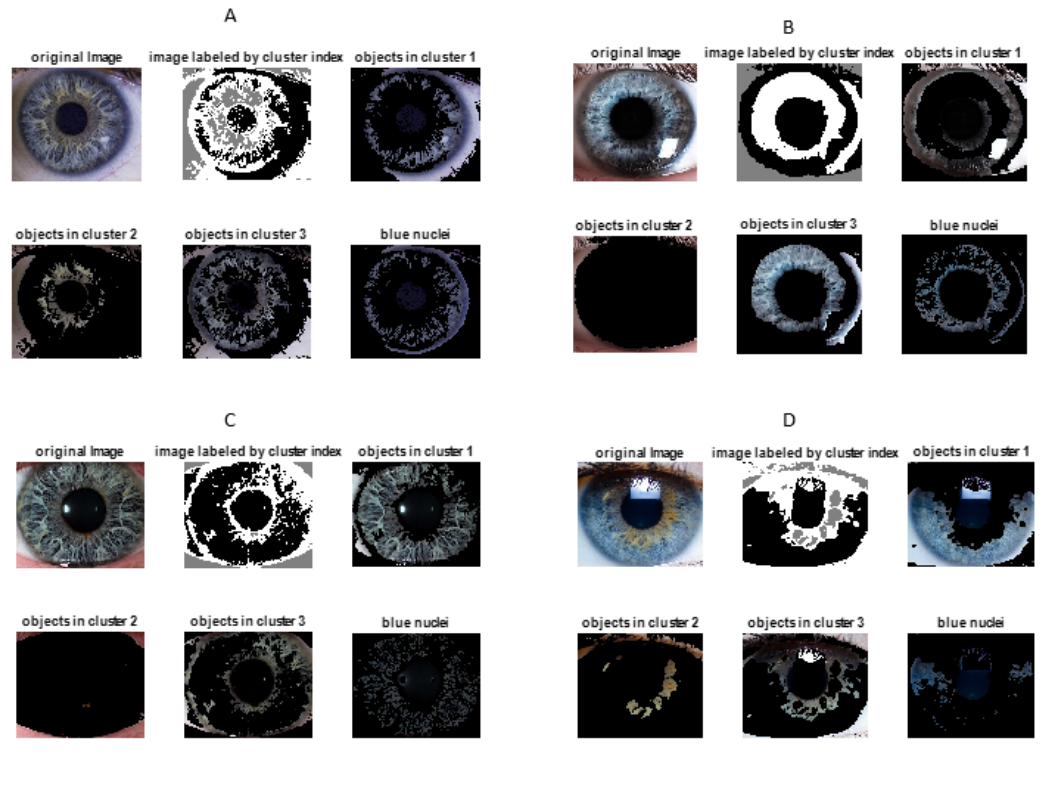
Figure 5. Clustering